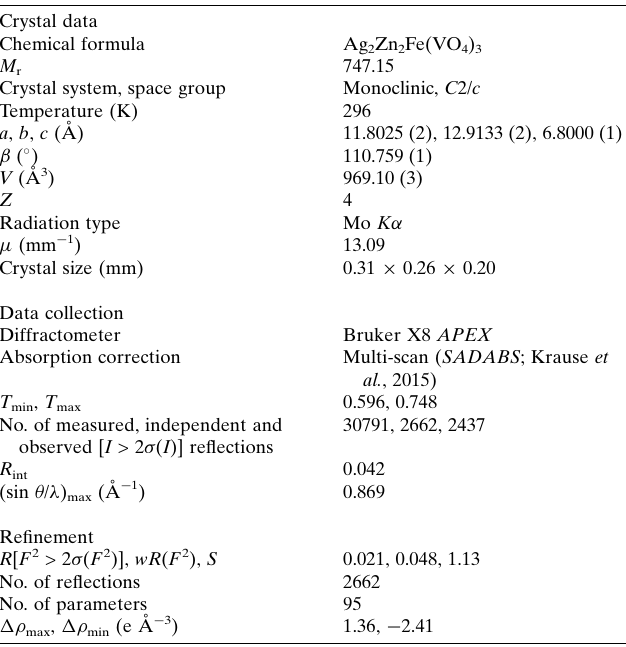
Table 1 Experimental details. Crystal data Chemical